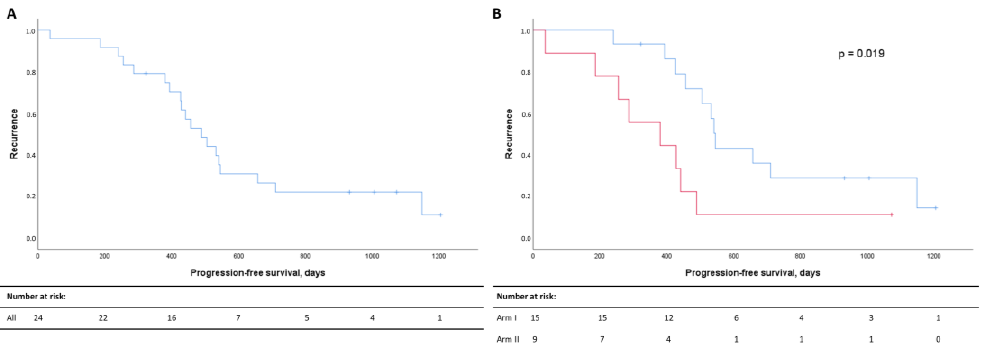
Figure 2. Kaplan–Meier curves for progression-free survival (PFS) for all patients ( A ) and for Arm I (blue) and Arm II (red) ( B ). PFS in days after diagnosis are listed on the x-axis, and the cumulative probabilities of recurrence in the cohort are shown along the y-axis. Censored data are indicated by small vertical lines. Numbers at risk across time are listed in the table below the Kaplan–Meier curves.